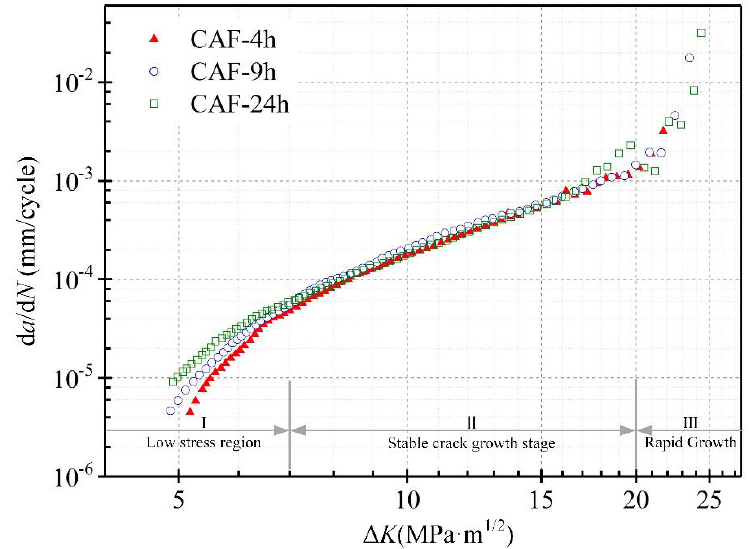
Figure 9. Fatigue crack growth rates of AA2524 under different creep age forming